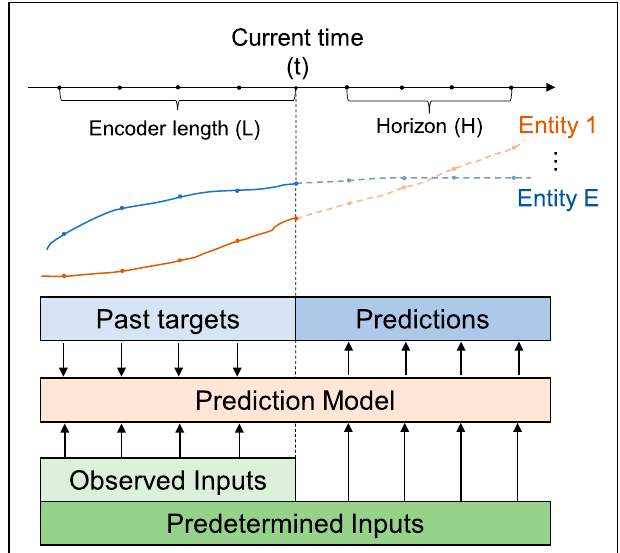
FIGURE 1 | Demonstration of a time-series forecasting problem with multiple entities.